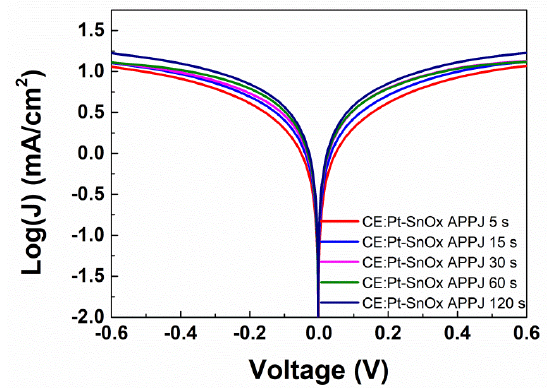
Figure 6. Tafel curves of symmetric cells with various Pt-SnO x CEs.